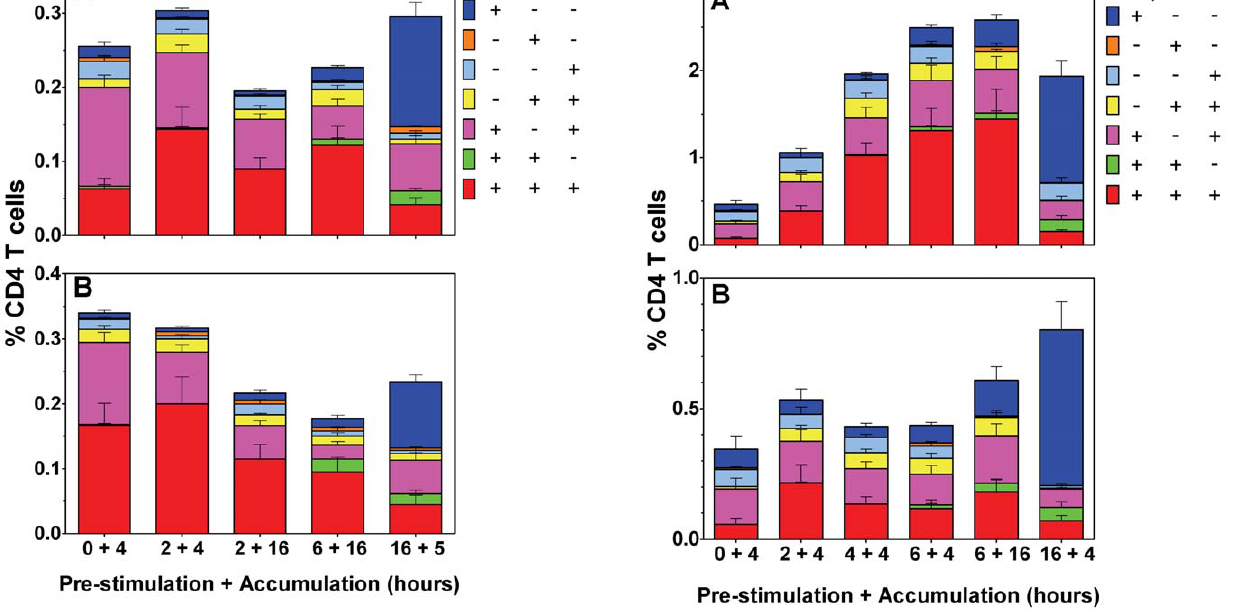
Figure 3. The effect of different culture schedules on antigen- specific bovine CD4 T cell responses. PBMC from cattle naturally infected with M. bovis were isolated, stimulated with PPD-B (A) or ESAT- 6/CFP-10 peptide pools (B), stained by intracellular cytokine staining (ICS) and interrogated by flow cytometry. Plots were gated on live CD4 + lymphocytes and analyzed for all combinations of simultaneous IFN- c , IL-2 and TNF- a productivity. The stacked bar graphs represent the percentage of antigen-specific CD4 + cells in the seven individual cell subsets, data is representative of one of three independent experiments (n=6). Bars represent the mean 6